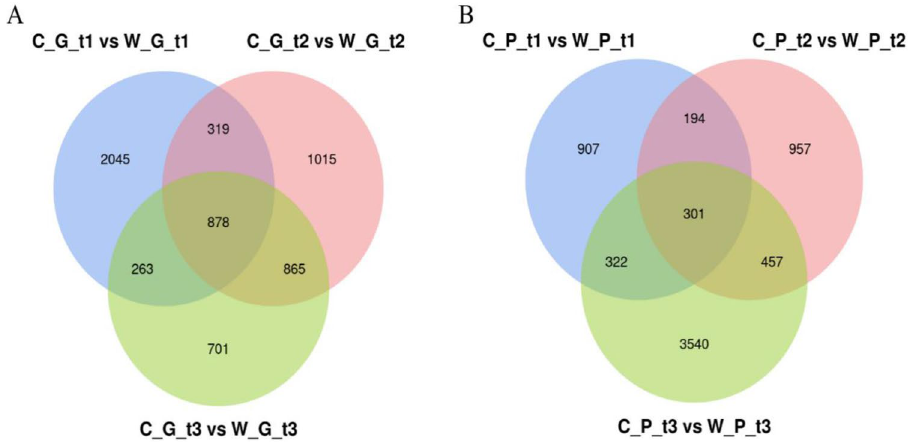
Figure 4. Venn diagram of differential expression of genes of ‘Pinot Noir’ and ‘Changbai No. 9’ in three periods of grapes ( A ) and peaches ( B )